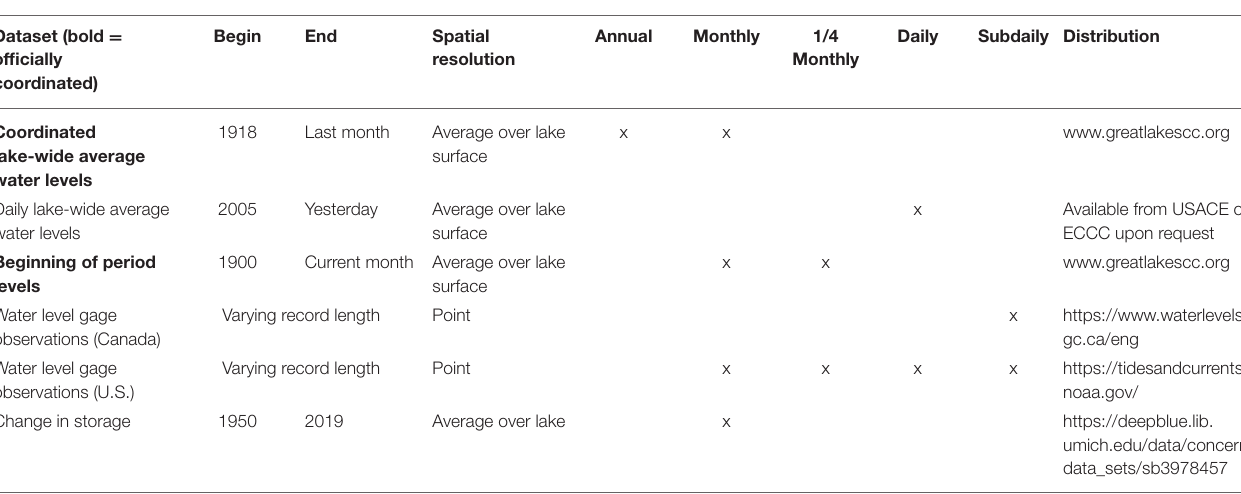
TABLE 1 | Water level data